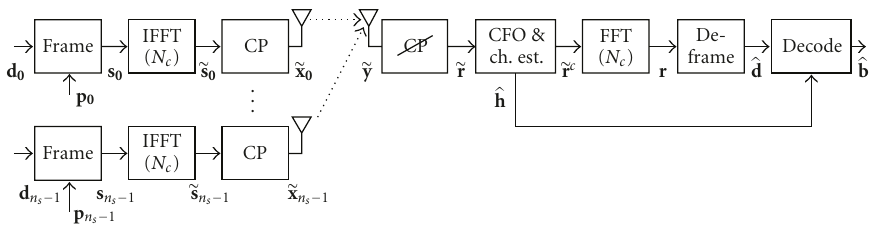
Figure 1: OFDM baseband system